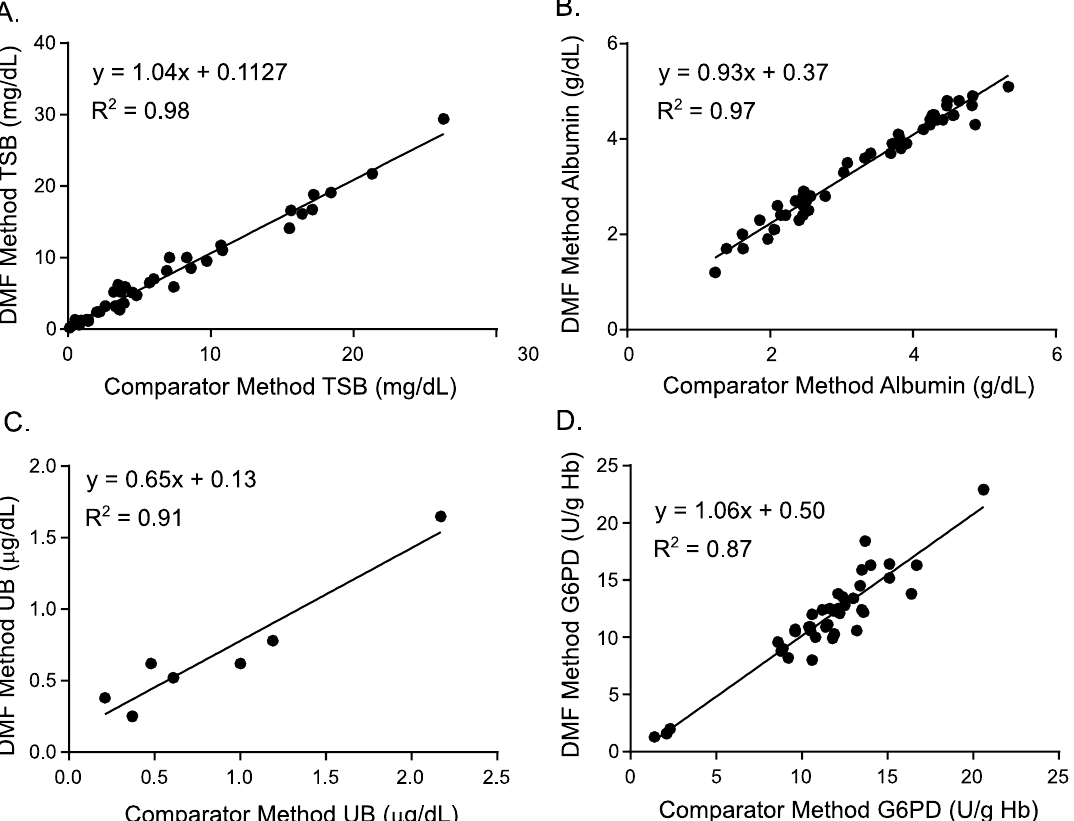
Figure 4. Method comparison results of the DMF assays (y-axis) to comparator laboratory assays performed at LabCorp (x-axis) for total bilirubin (TBil) ( A ), albumin ( B ), and glucose-6-phosphate dehydrogenase (G6PD) ( D ), or using an in vitro diagnostic comparator method for unbound bilirubin ( C ).